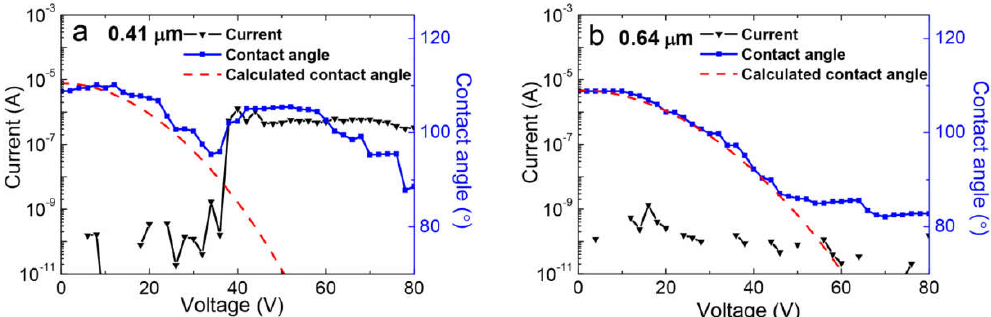
Figure 6. Leakage current and electrowetting measurement of Cytop coatings with thicknesses of ( a ) 0.41 µ m and ( b ) 0.64 µ m. Measured current in black (left axis) and contact angle data in blue (right axis) with Equation (1) modeled (red dashed line).